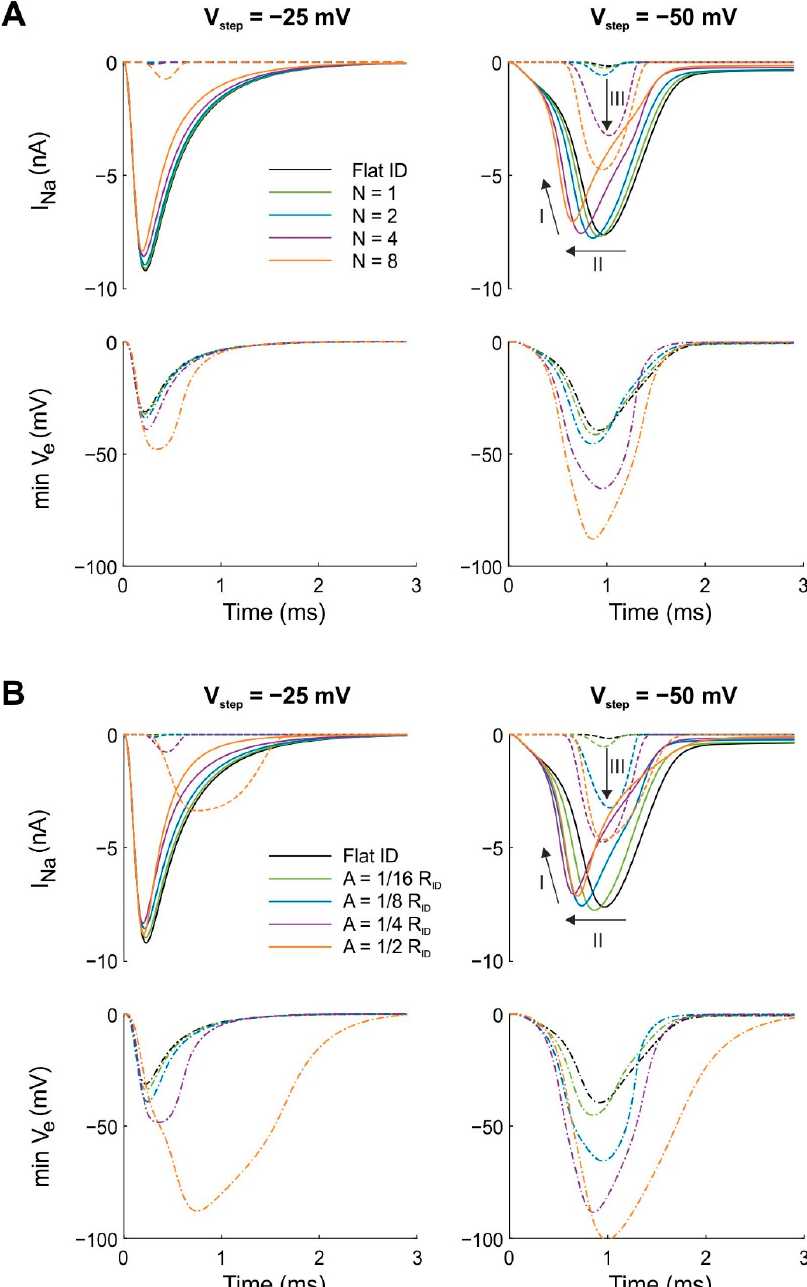
Figure 2. Effects of the number of folds N and the amplitude of folds A for concentric folds on I Na and minimal V e for a uniform distribution of g Na . The intracellular potential of the pre-junctional cell was subjected to a voltage clamp protocol with V step = –25 mV (left) and V step = –50 mV (right) while the intracellular potential of the post-junctional cell was clamped at resting membrane potential. The cleft width was set to 30 nm and gap junctional coupling was set to zero. Continuous and dotted curves correspond to I Na in the pre- and post-junctional membranes, respectively. Dashed-dotted lines represent minimal V e . Reference simulations with a flat intercalated disc (ID) are shown in black. ( A ) The amplitude of the folds was kept constant (A = 1/4 R ID ) while the number of folds was varied from 1 to 4. ( B ) The number of folds was kept constant (N = 4) while their amplitude was varied from 1/16 R ID to 1/2 R ID . Arrows: I: self-attenuation of I Na in the pre-junctional membrane; II: self-activation in the pre-junctional membrane; III: self-activation in the post-junctional membrane.